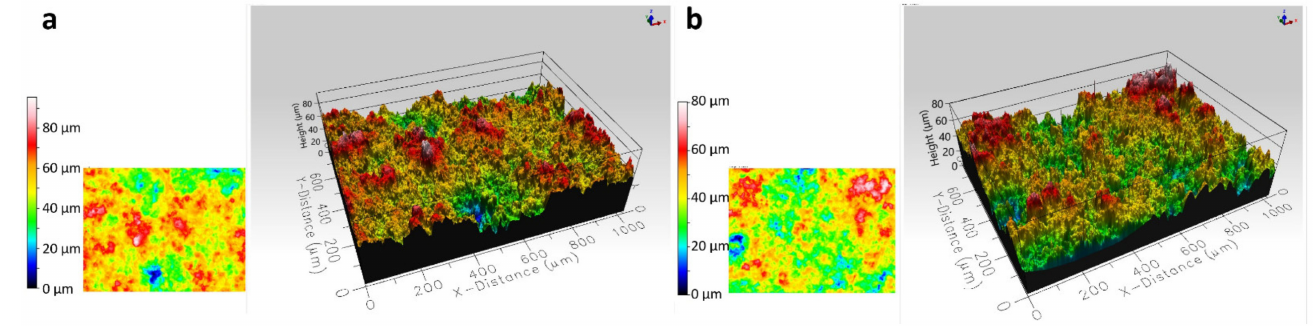
Figure 5. Surface topography of the (Cr 3 C 2 -25(Ni20Cr))-5(Ni25C) coatings: on the Al 7075 alloy ( a ), on the 1H18N9T steel ( b